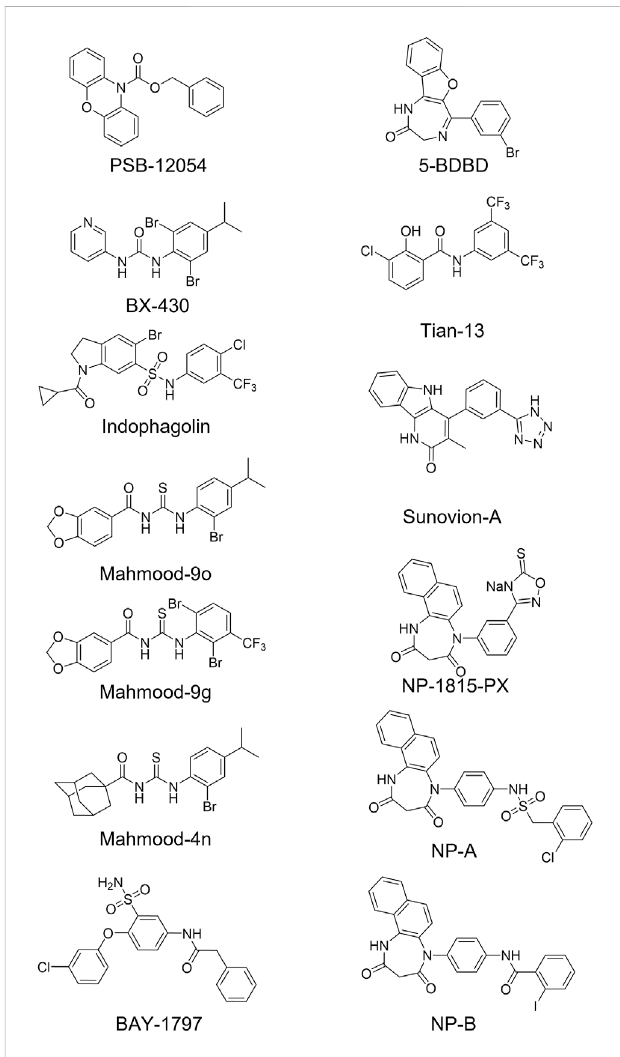
date. In this study, two of the most potent NipponChemipharm (NP) compounds series have been arbitrarily named NP-A and NP-B, the compound patented by Souvion is referred to as Souvion-A. Compound 4n [Mahmood et al. (2022a)] and compounds 9g and 9o [Mahmood et al. (2022b)] are referred to as Mahmood 4n, Mahmood 9g, and Mahmood 9o. Compound 13 (Tian M. et al., 2020) is referred to as Tian